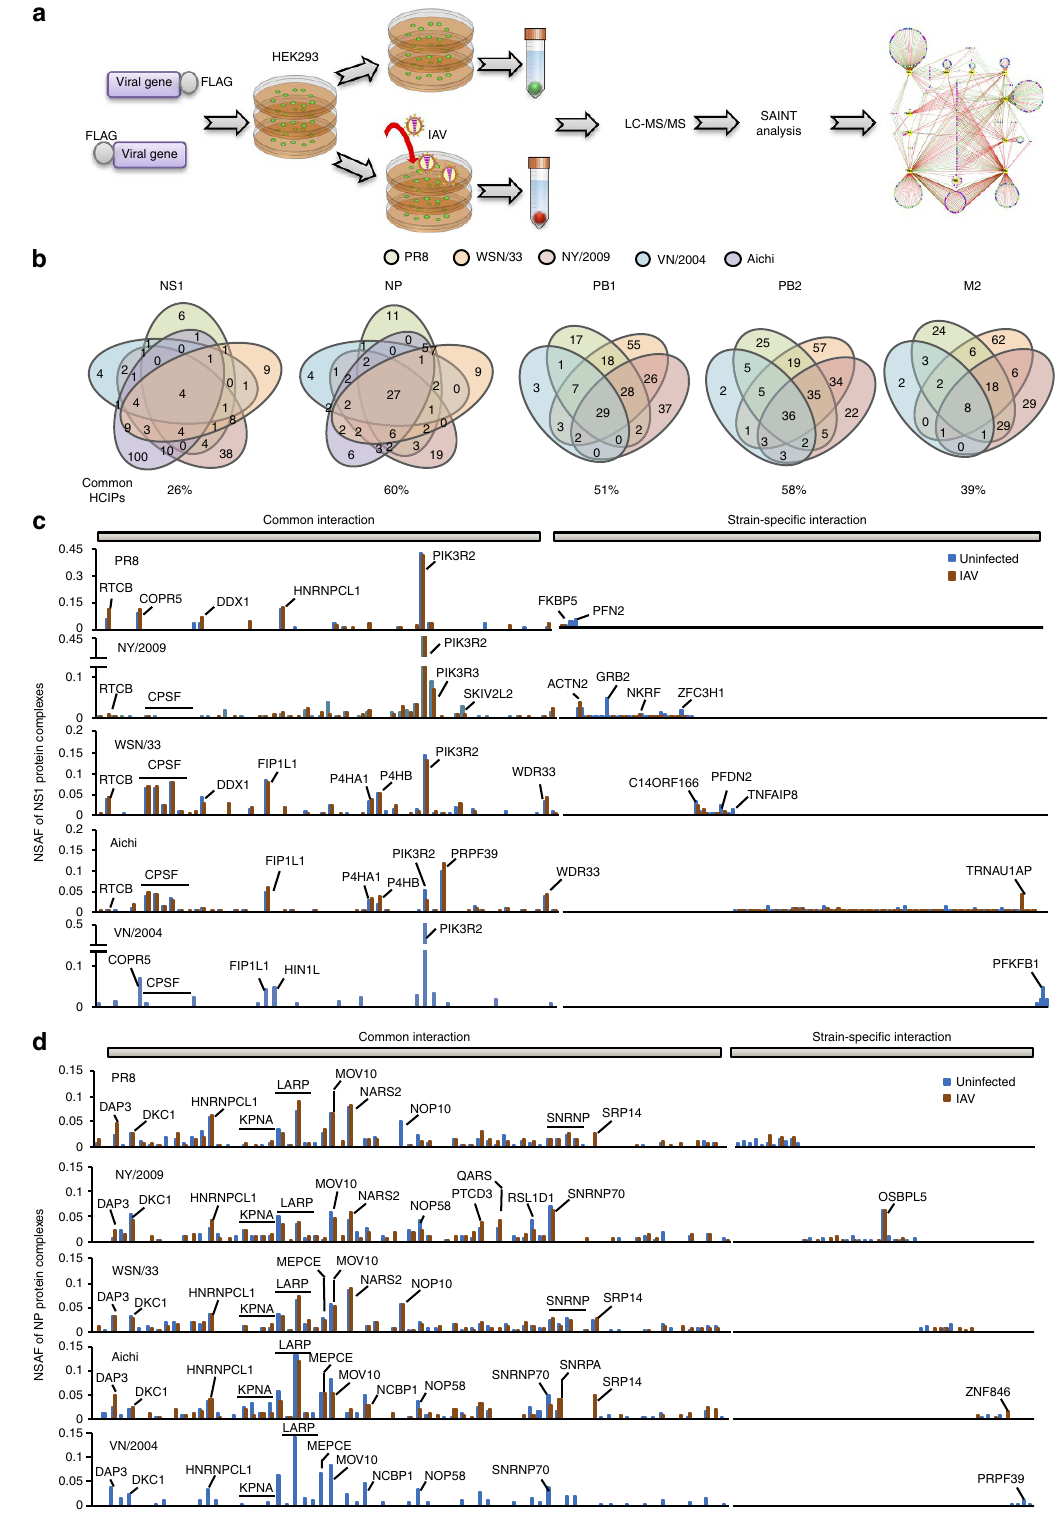
Figure 1 | Comparative analysis of IAV–host interactomes. ( a ) Pipeline of AP-MS for mapping IAV–host protein interactomes. ( b ) The Venn diagrams illustrate the number of common HCIPs (in Z 2 strains) in viral protein complexes from different IAVstrains. The percentage of common HCIPs is indicated. ( c , d ) Comparison of the relative abundances of HCIPs of each NS1 ( c ) and NP ( d ) from five IAV strains. The outstanding HCIPs are labelled. NSAF stands for normalized spectral abundance factor.